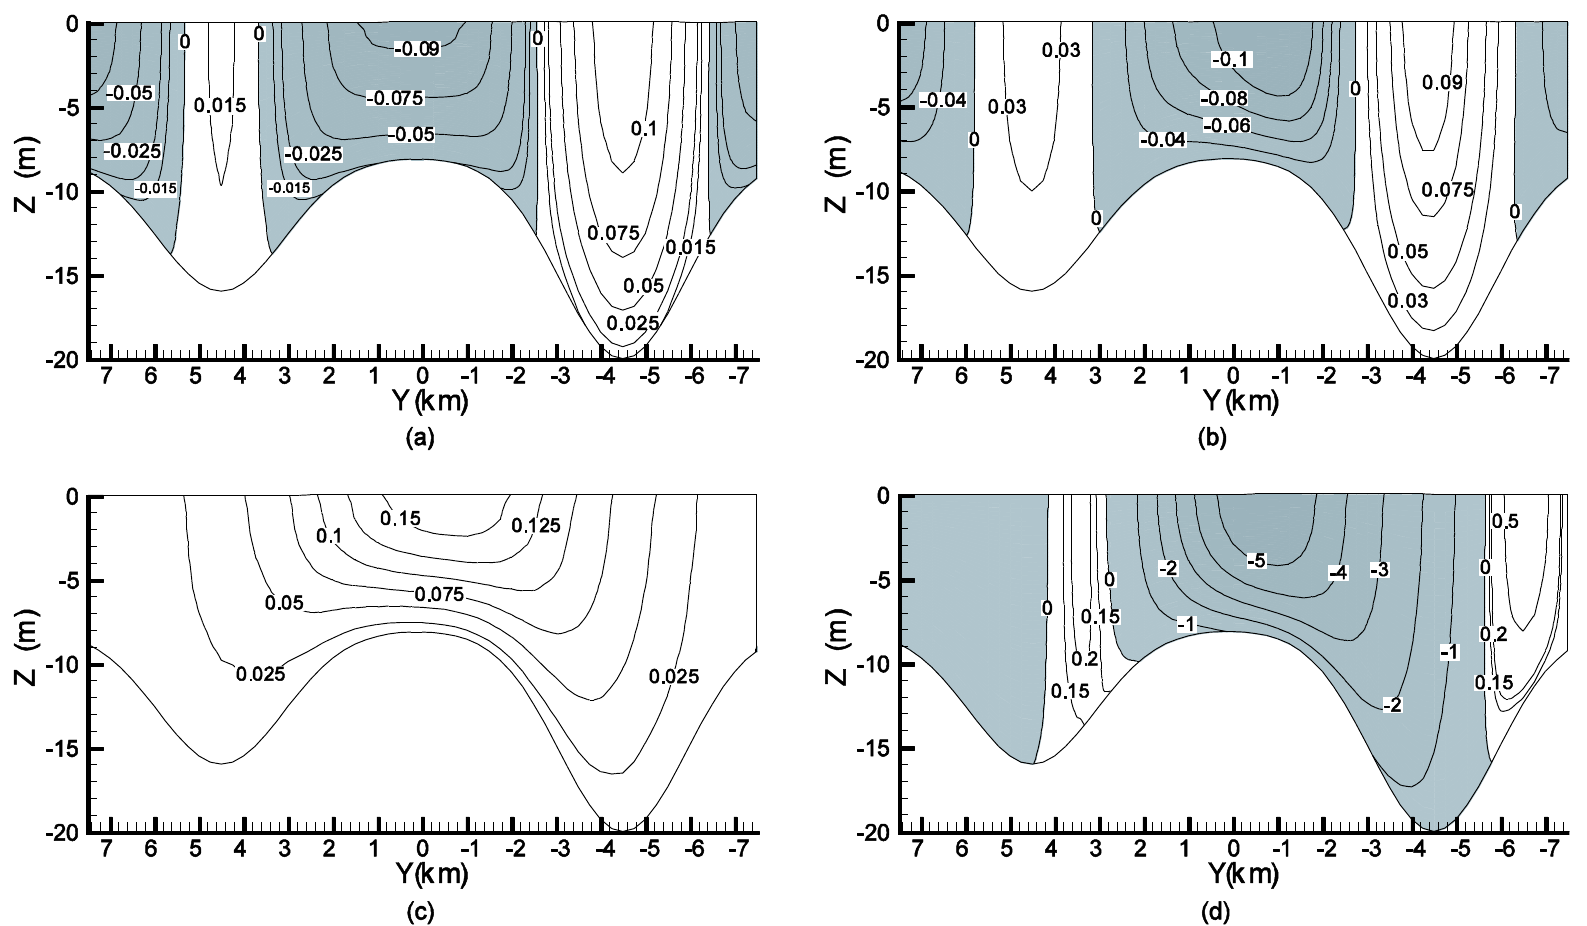
Figure 6. Contours of u x velocity (m/s) at ( a ) x = 50 km and ( b ) x = 98 km and contours of u y velocity (m/s × 10 −2 ) at ( c ) x = 50 km and ( d ) x = 98 km for the density-driven case. The dark areas represent negative velocities.